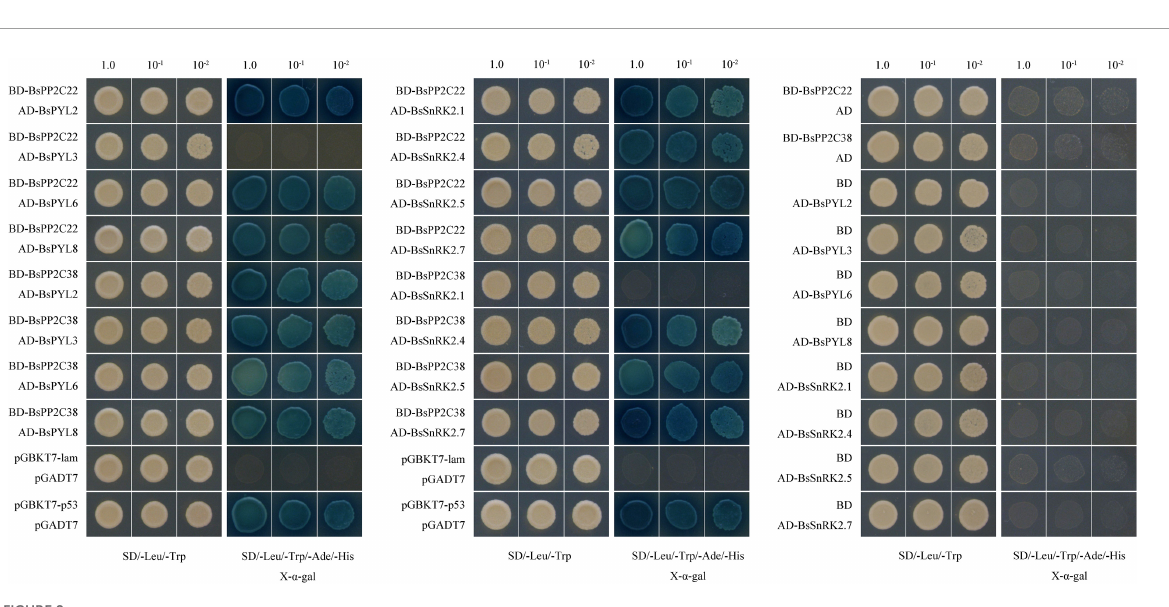
FIGURE8 Yeast two-hybrid (Y2H) assays to test the interactions between BsPP2C22 (BsPP2C38) and BsPYLs, as well as BsPP2C22 (BsPP2C38) and BsSnRK2s. BsPP2C22 (BsPP2C38) was fused with the DNA-binding domain (BD), while BsPYLs and BsSnRK2s were fused with the activation domain (AD). Positive control (pGBKT7-p53 + pGADT7), negative control (pGBKT7-lam + pGADT7), BD-BsPP2C38 + AD-BsPYLs (BsSnRK2s) groups, BD-BsPP2C38 + AD group, and BD + AD-BsPYLs (BsSnRK2s) groups and were grown on SD/-Leu/-Trp/-Ade/-His + X- α -gal media. BD-BsPP2C22 + AD-BsPYLs (BsSnRK2s) groups and BD-BsPP2C22 + AD were grown on SD/-Leu/-Trp/-Ade/-His + X- α -gal + 40 µ M 3-AT